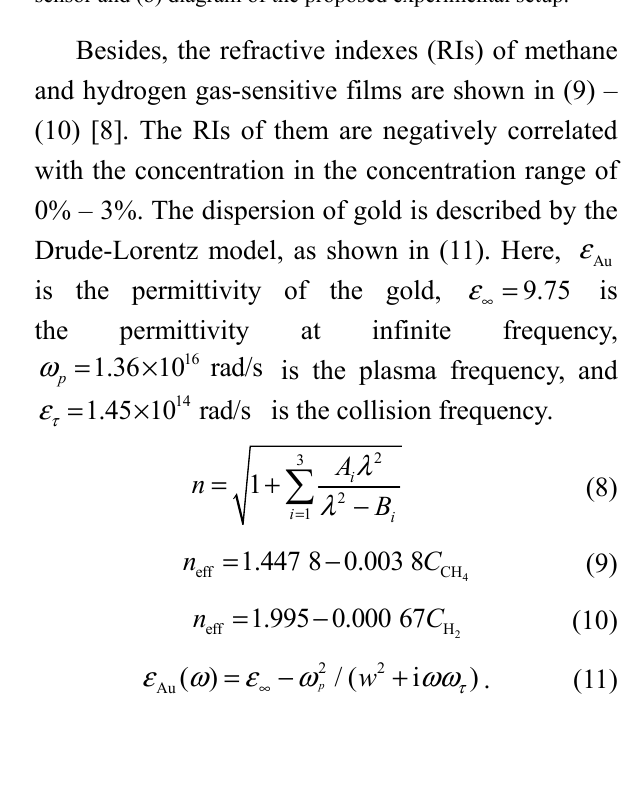
Fig. 1 Schematic diagram of the optical fiber structure and experimental device: (a) cross-section diagram of the D-PCF sensor and (b) diagram of the proposed experimental